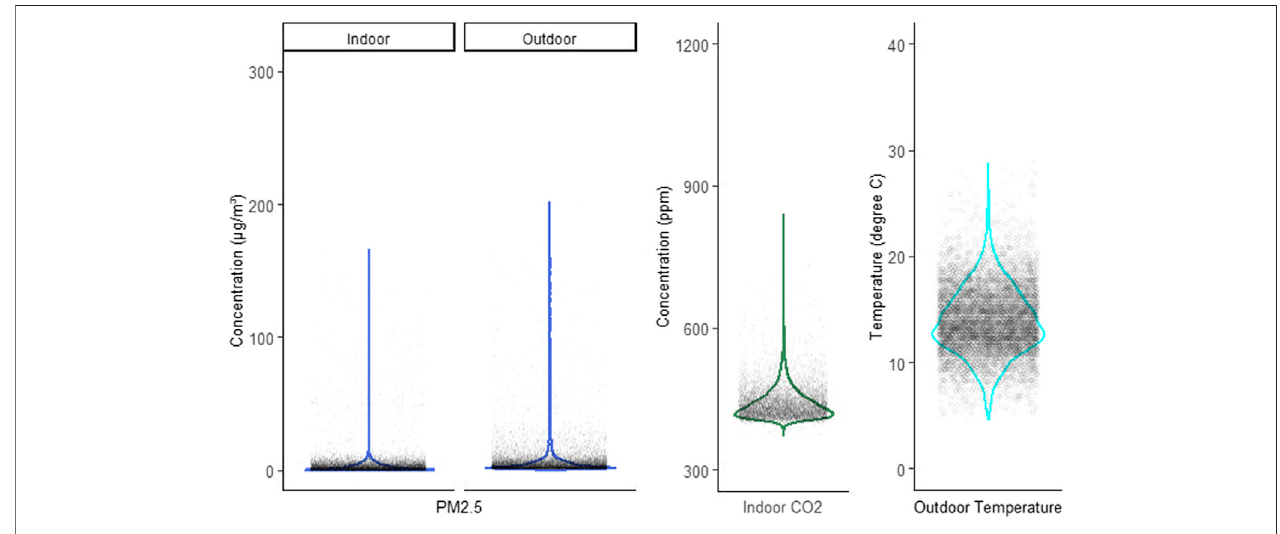
FIGURE 2 | Hourly averaged indoor and outdoor PM 2.5 , CO 2 , and temperature.